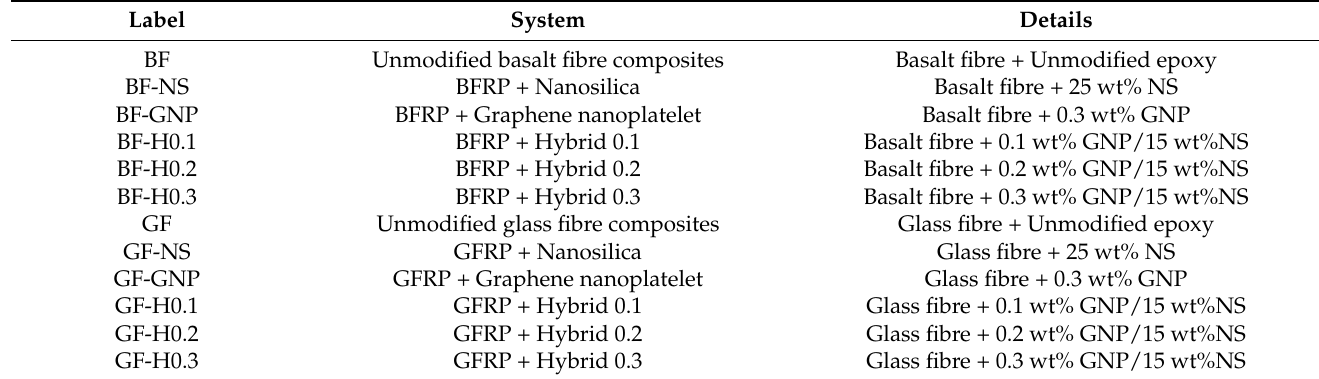
Figure 2. The schematic diagram for the fabrication of hybrid GNP-NS/epoxy composites. Table 1. Designation of fabricated